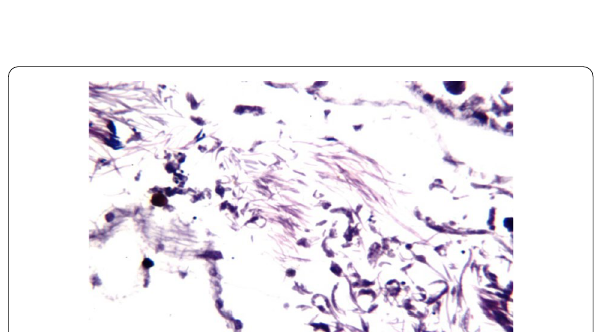
Fig. 2 Showed the normal spermatozoa in the sac. of untreated